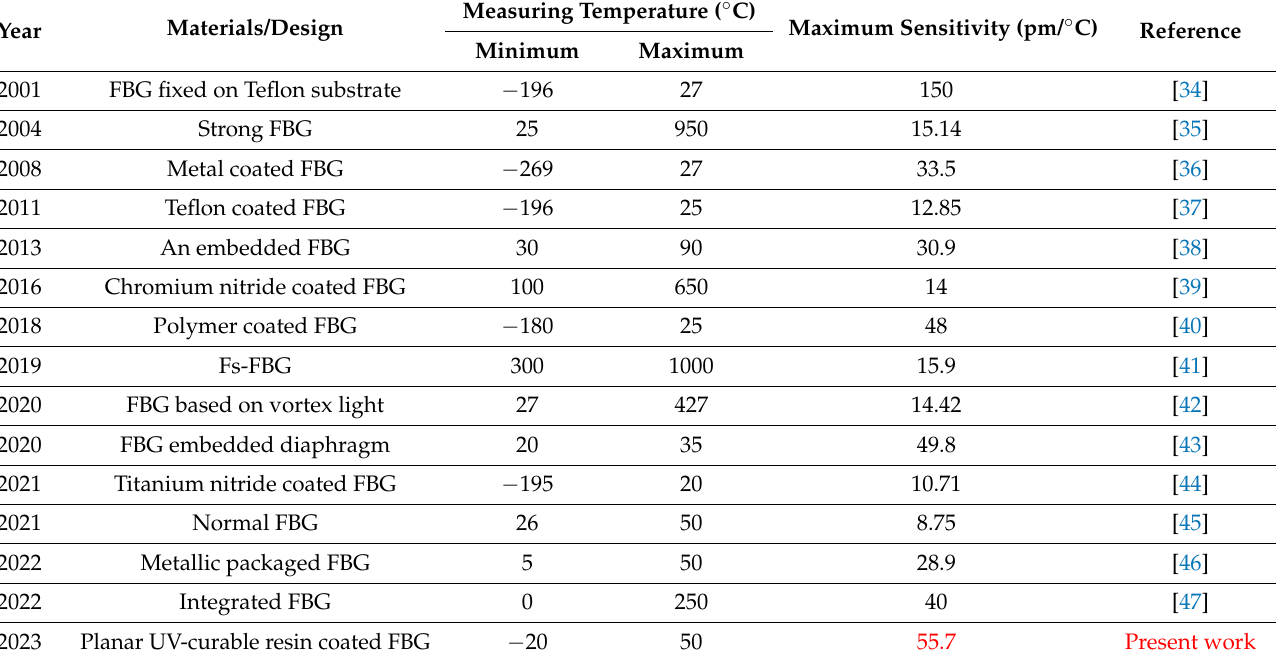
Table 2. Performance comparisons of various FBG sensors reported in the last 20 years (in chronolog- ical